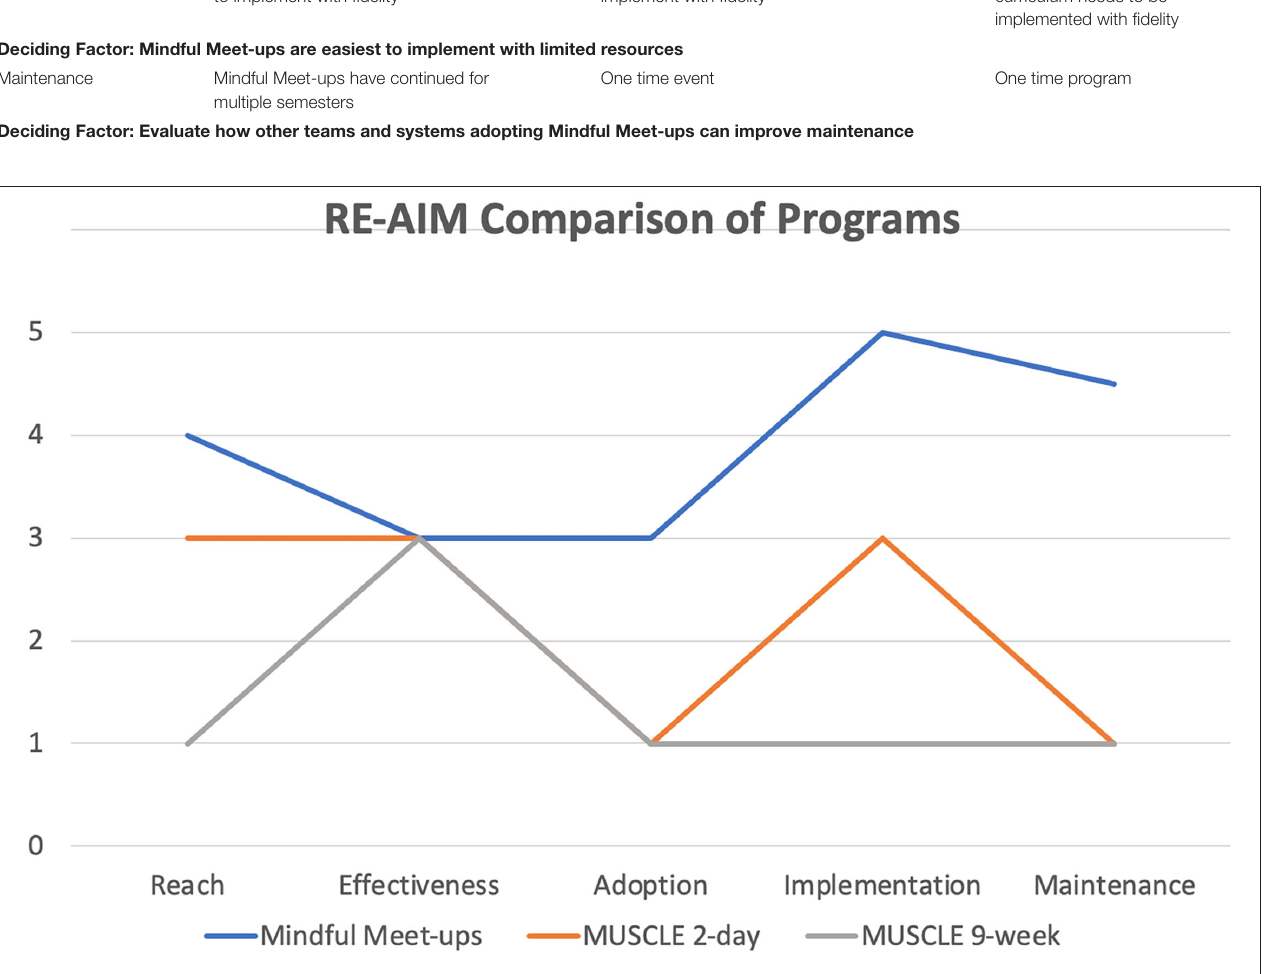
2-day was based on two denominators: (1) all agents in VCE and (2) agents who attended Mindful Meet-ups, for 33.2 and 91.3%, respectively. Phase II was considered a 3 for